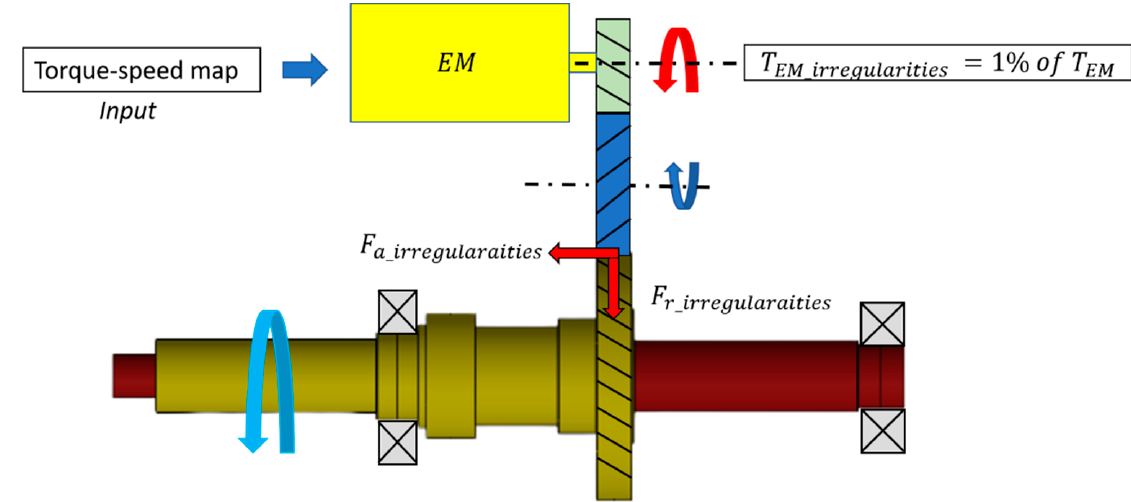
Figure 16. Description of the torque transmission path.